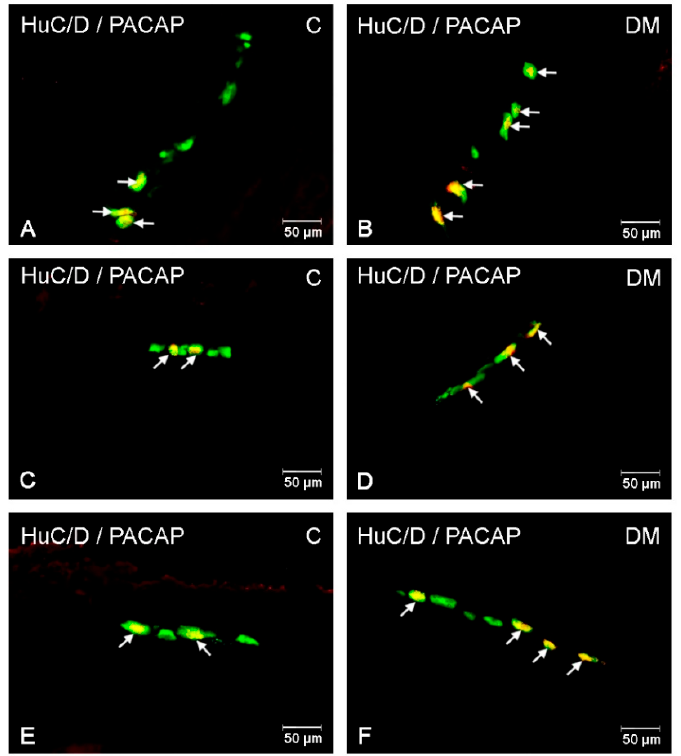
Figure 5. PACAP- LI enteric neuron in the porcine descending colon. ( A )—neurons immunoreactive to HuC/D (panneuronal marker) and PACAP in the myenteric plexus in the descending colon of control pigs; ( B )—neurons immunoreactive to HuC/D (panneuronal marker) and PACAP in the myenteric plexus in the descending colon of diabetic pigs; ( C )—neurons immunoreactive to HuC/D (panneuronal marker) and PACAP in the outer submucous plexus in the descending colon of control pigs; ( D )—neurons immunoreactive to HuC/D (panneuronal marker) and PACAP in the outer submucous plexus in the descending colon of diabetic pigs; ( E )—neurons immunoreactive to HuC/D (panneuronal marker) and PACAP in the inner submucous plexus in the descending colon of control pigs; ( F )—neurons immunoreactive to HuC/D (pan-neuronal marker) and PACAP in the inner submucous plexus in the descending colon of diabetic pigs. All pictures were created by digital superimposition of two colour channels (green for HuC/D and red for